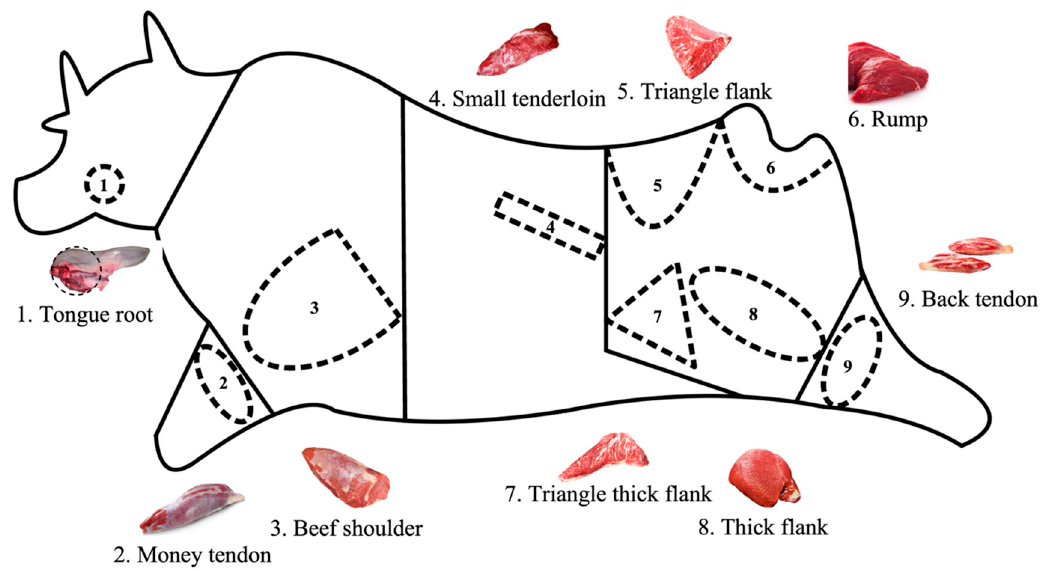
Figure 1. The distribution map of cattle carcass traits involved in this study.